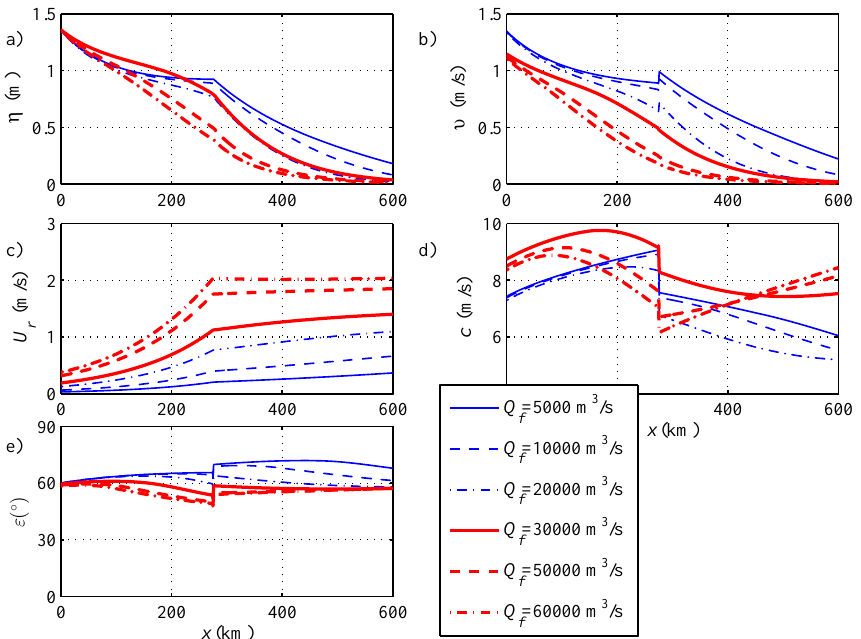
Figure 10. Longitudinal variation of the tidal amplitude η (a) , the velocity amplitude υ (b) , the river flow velocity U r (c) , the wave celerity c (d) , and the phase lag ε (e) in the Yangtze estuary under different river discharge conditions.